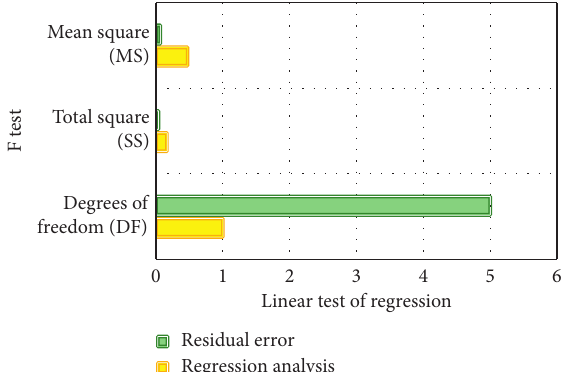
Figure 5: Regression statistics result.